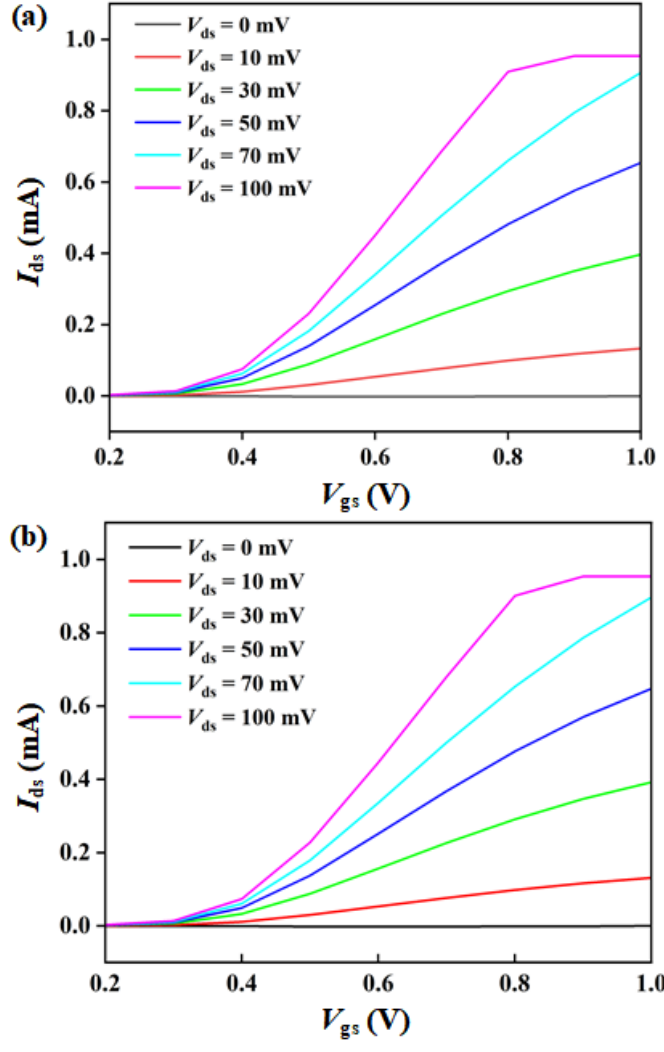
Figure 5. Output characteristic curves as a functions of the V gs for various V ds : ( a ) symmetrical detector and ( b ) asymmetrical detector.